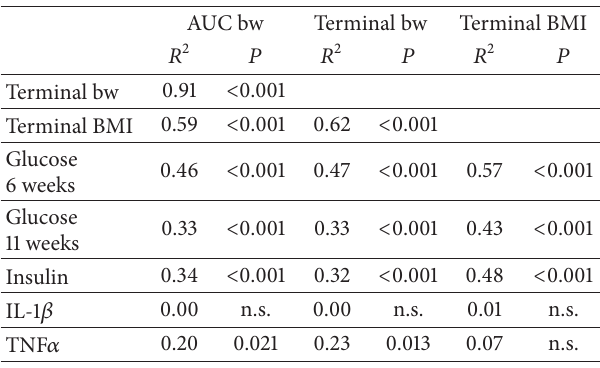
Table 2: Associations between various parameters for body weight and glucose, insulin and cytokine